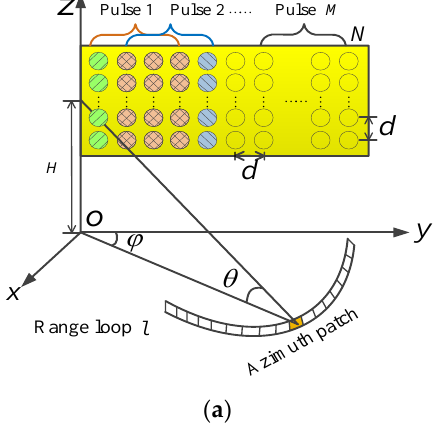
Figure 4. The sketch map of multichannel sea clutter measurement system: ( a ) transmit and receive array; ( b ) transmit subarray moves cyclically as the CPI changes.